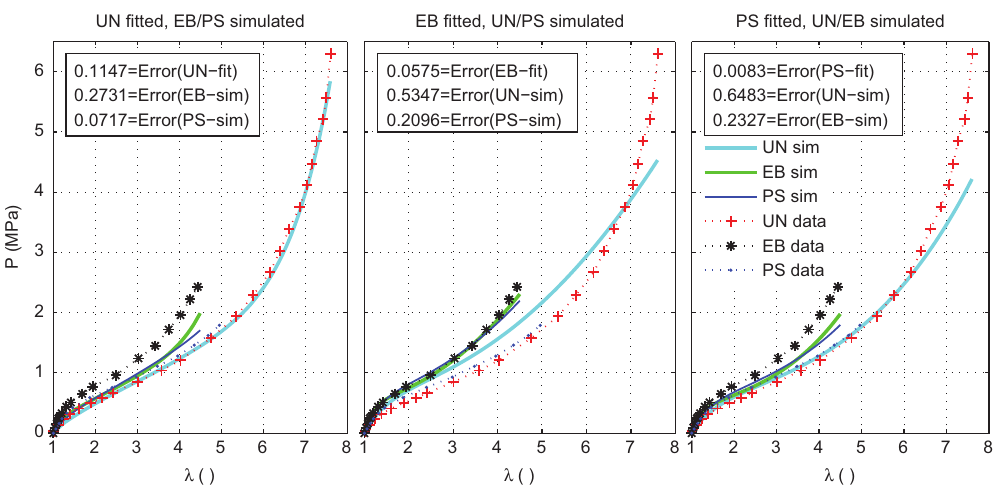
Figure 9 Performance of the Lopez-Pamies model on the Treloar data. The fitting quality is quite convincing, especially if compared with models having four parameters such as the Alexander model or van der Waals